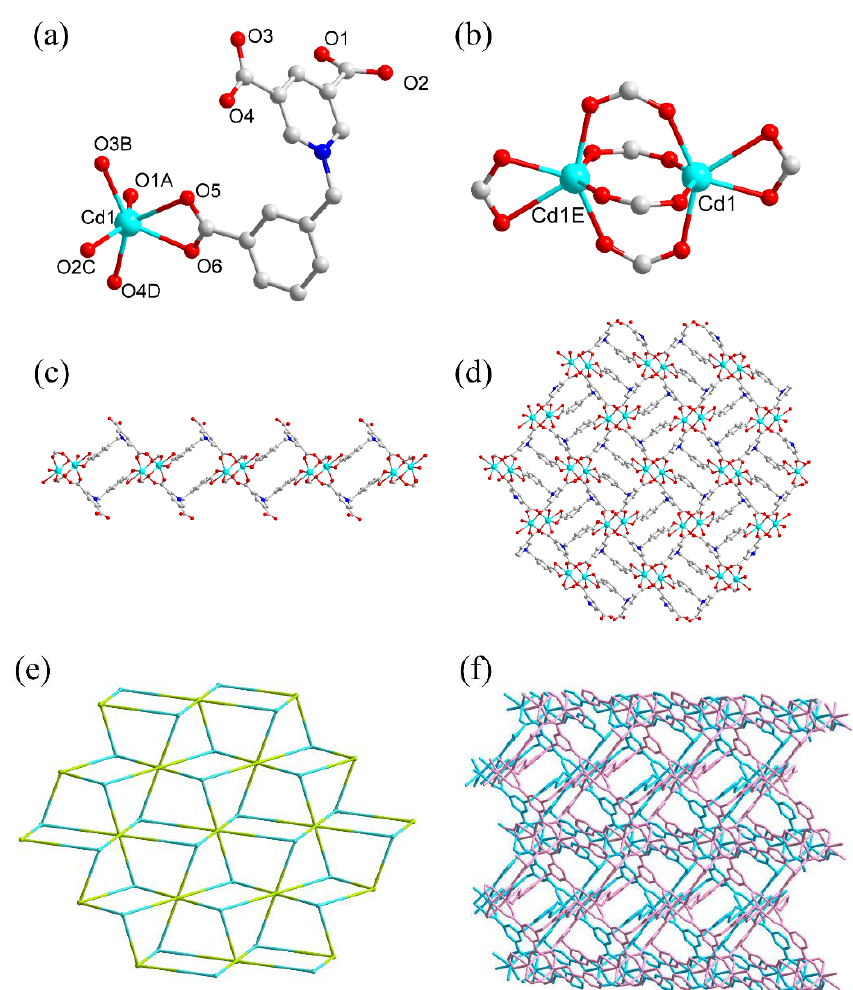
Figure 1. ( a ) Coordination environment of the {[Cd 4 (Dccbp) 4 ] · H 2 O} (coordination polymers (CP) 1 ) (symmetry codes: (A) − x+2, − y+1, − z+1; (B) − x+2,y − 1/2, − z+1/2; (C) x,y − 1,z; (D) x, − y+1/2,z+1/2). ( b ) Coordination geometries of the dinuclear subunits generated by Cd1 atoms and carboxylate groups. ( c ) The One-dimensional infinite bead chain in CP 1 . ( d ) The 2-dimensional structure of CP 1 . ( e ) The kgd topology of 1 . ( f )The 3D supramolecular architecture of 1